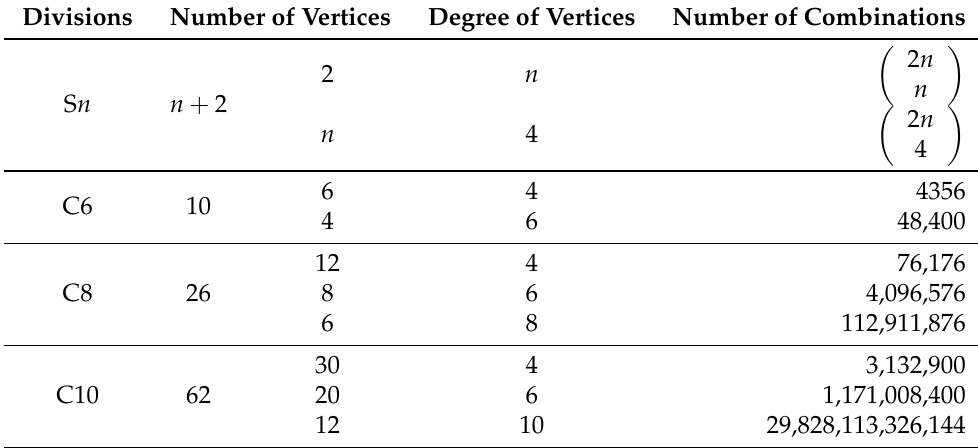
Table 2. Basic properties of SphereHarmonic